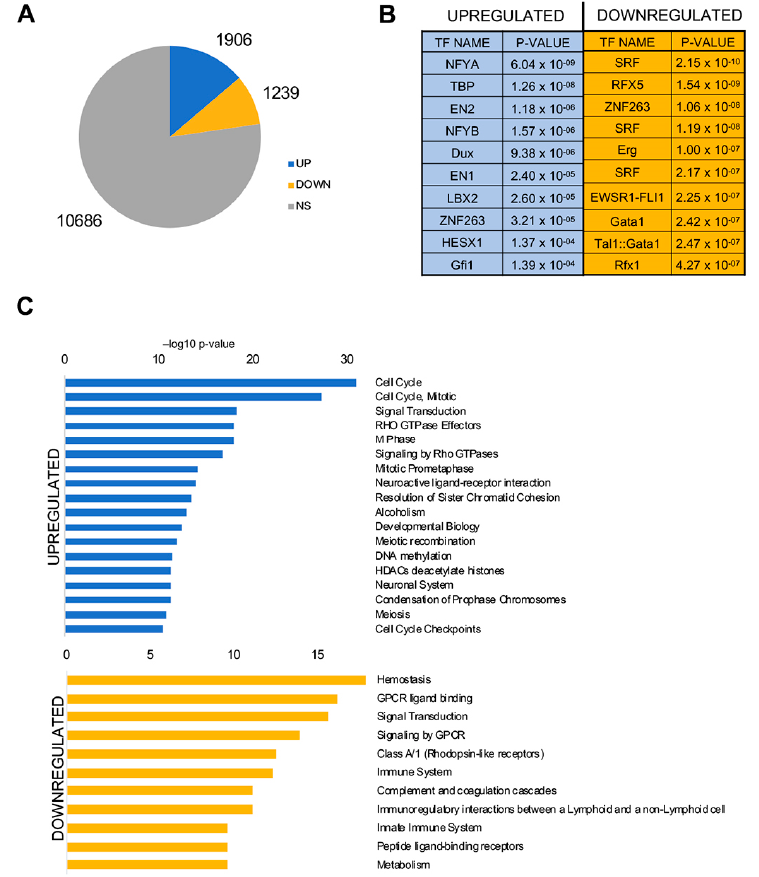
Figure 4. Gene expression analysis of the whole set of 501 LUSC TCGA tumors. ( A ) Up- and down-regulated genes in tumors versus normal lung tissues. ( B ) Pscan analysis of enriched TFBS in promoters (–450/+50 bps from the TSS) of up- (left panel) and down-regulated (right panel) genes in tumors. ( C ) Reactome pathways enriched in commonly upregulated genes (upper panel) and down-regulated genes (lower panel) listed according to their p value. The list is obtained using KOBAS.